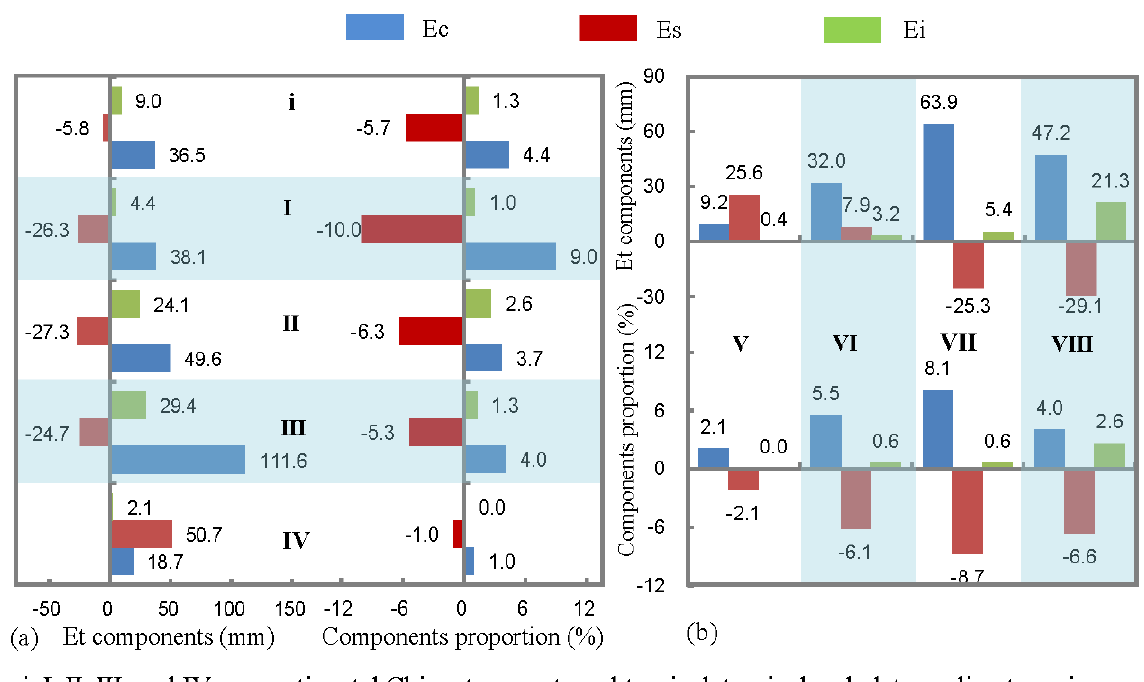
Figure 4. The annual mean ET components for different climate zones and moisture regions.